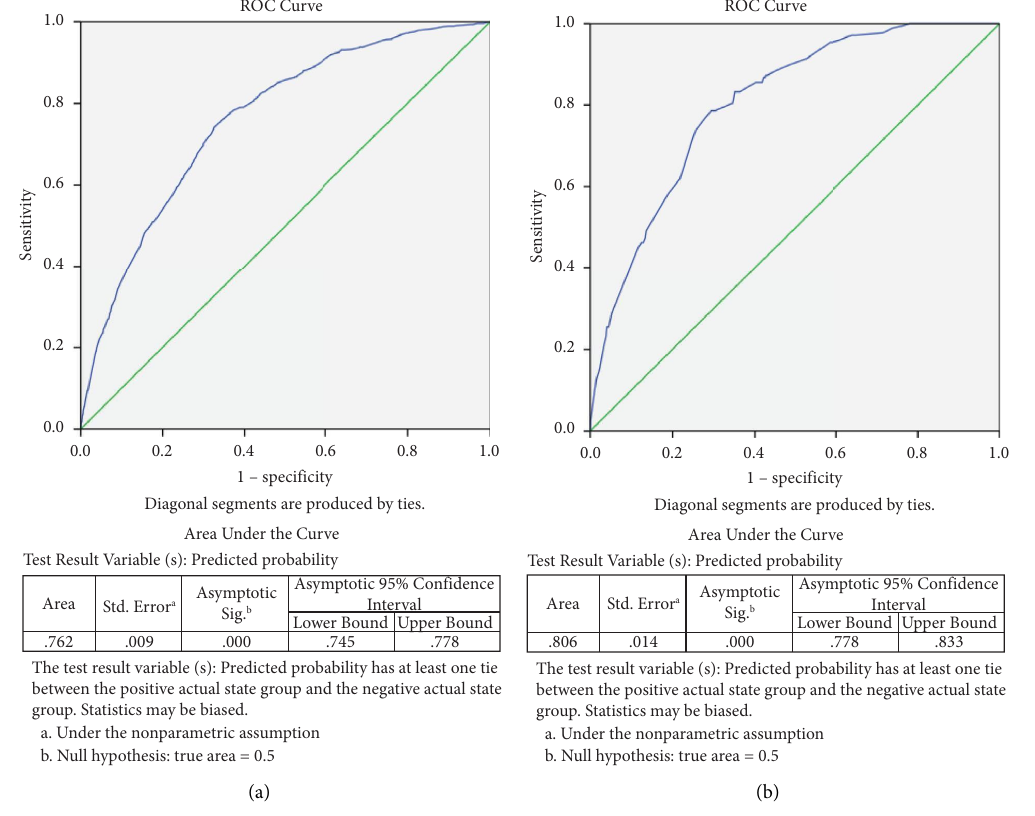
Figure 3: Area under the curve for the association between classical cardiovascular (CV) risk factors and hospitalization (a) and mortality (b)